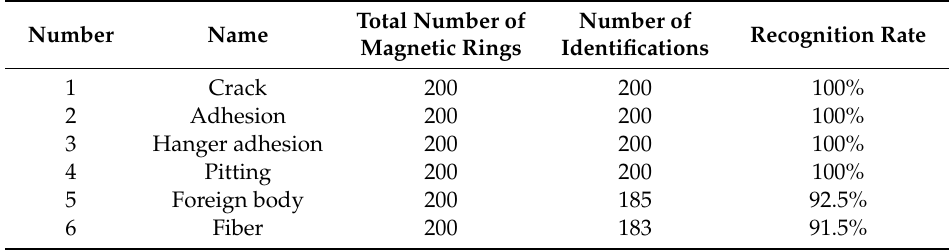
Table 2. Defect detection